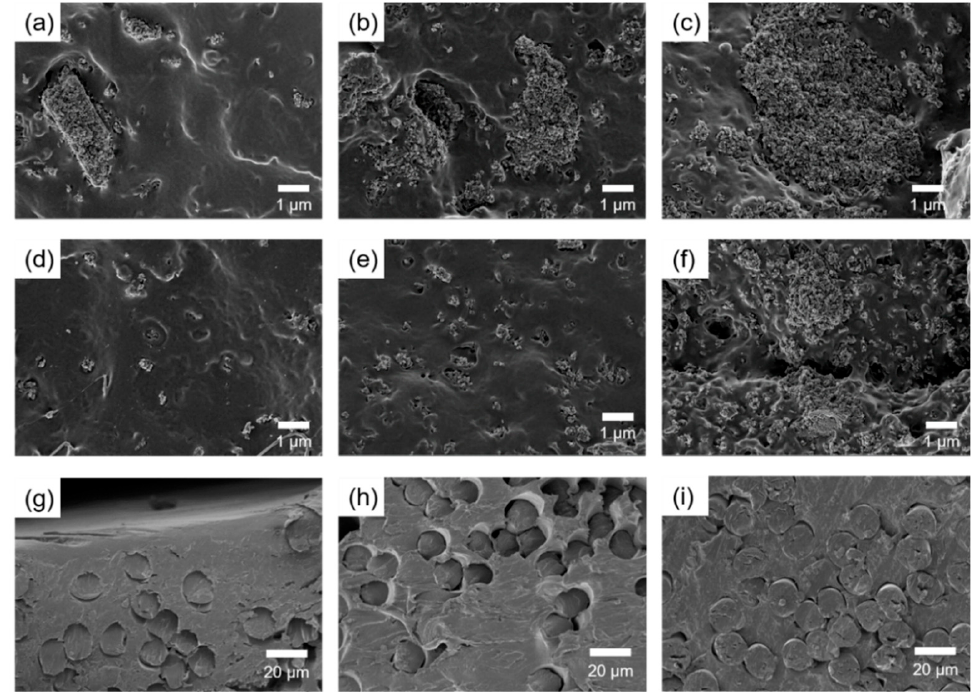
Figure 2. SEM images of fracture surface of ( a ) PLA/HA5, ( b ) PLA/HA10, ( c ) PLA/HA15, ( d ) PLA/HA-g-PLA(m)5, ( e ) PLA/HA-g-PLA(m)10, ( f ) PLA/HA-g-PLA(m)15, ( g ) PLA/PGA fiber10, ( h ) PLA/PGA fiber20, and ( i ) PLA/PGA fiber30.